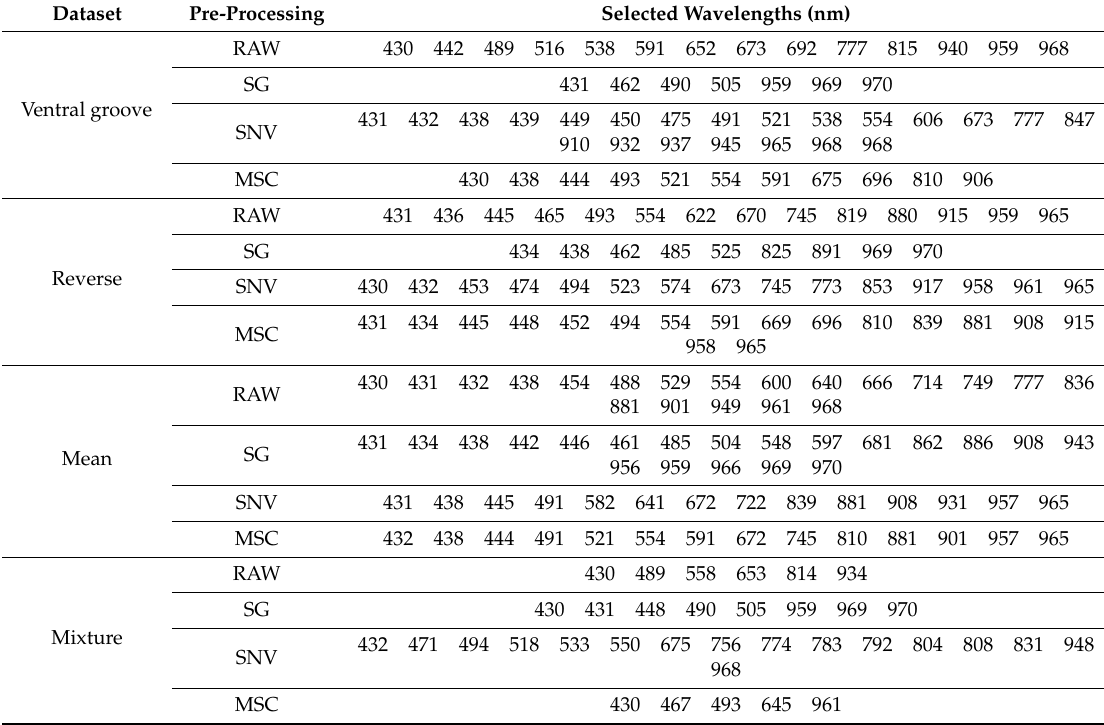
Table 2. Selected wavelengths by successive projections algorithm